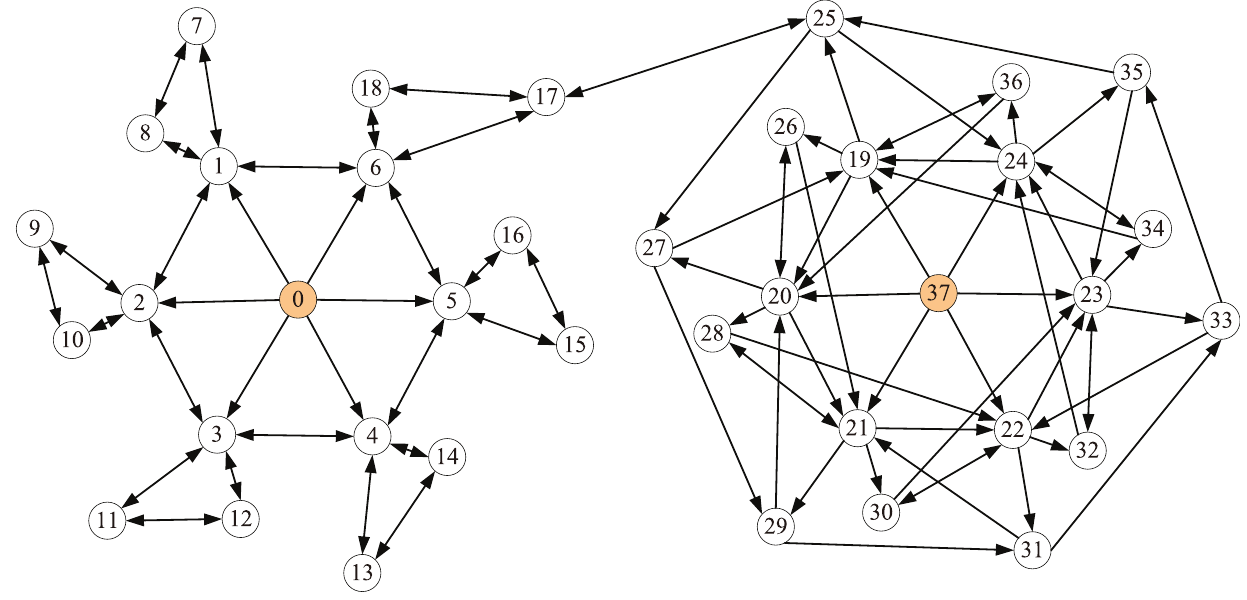
Figure 3. An example network with 38 nodes and 110 directed edges. Although nodes 0 and 37 have the same out-degree, node 37 is of higher influence (subject to spreading dynamics) than node 0. The clustering coefficients of these two nodes are c 0 ~ 0 : 4 and c 37 ~ 0 : 2